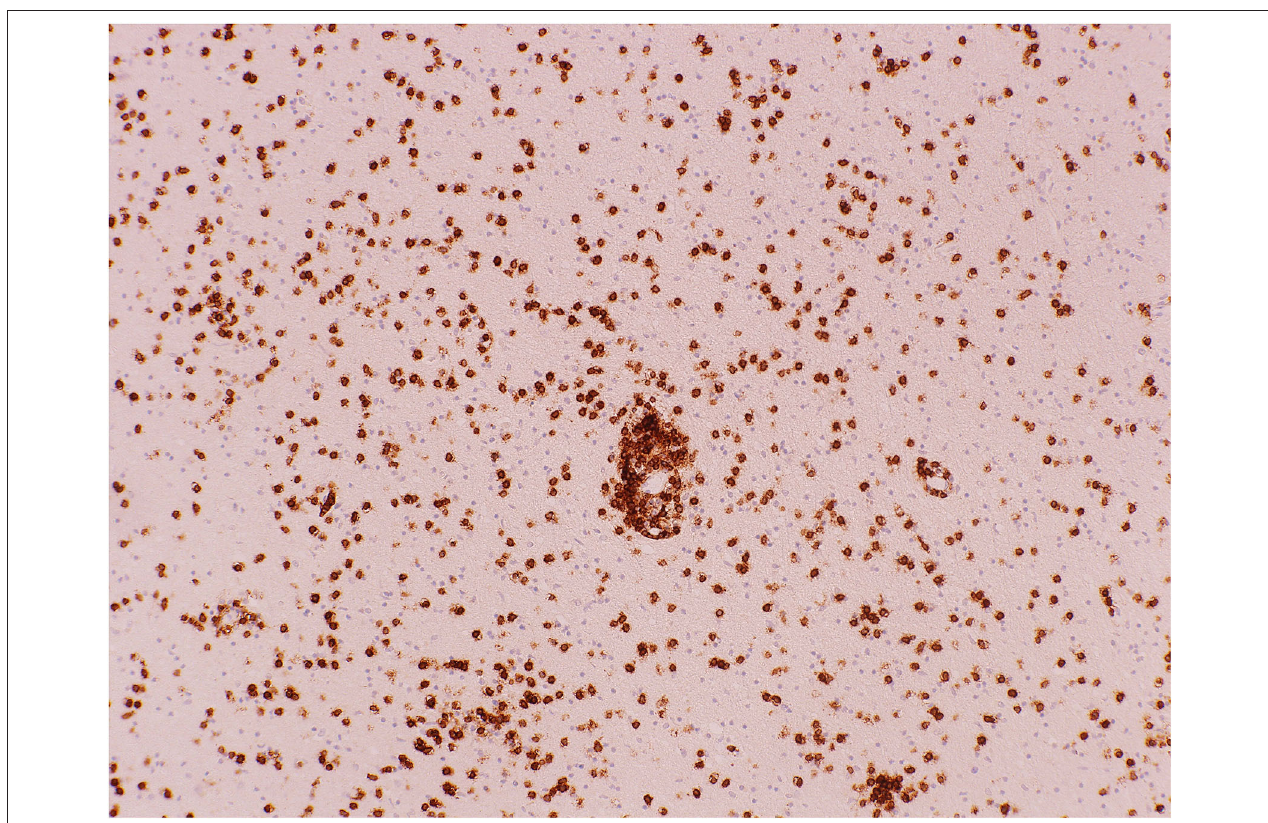
FIGURE 6 | Cerebral white matter: CD8 + T-cells demonstrated with immunohistochemistry (antibody against CD8). Original magnification ×